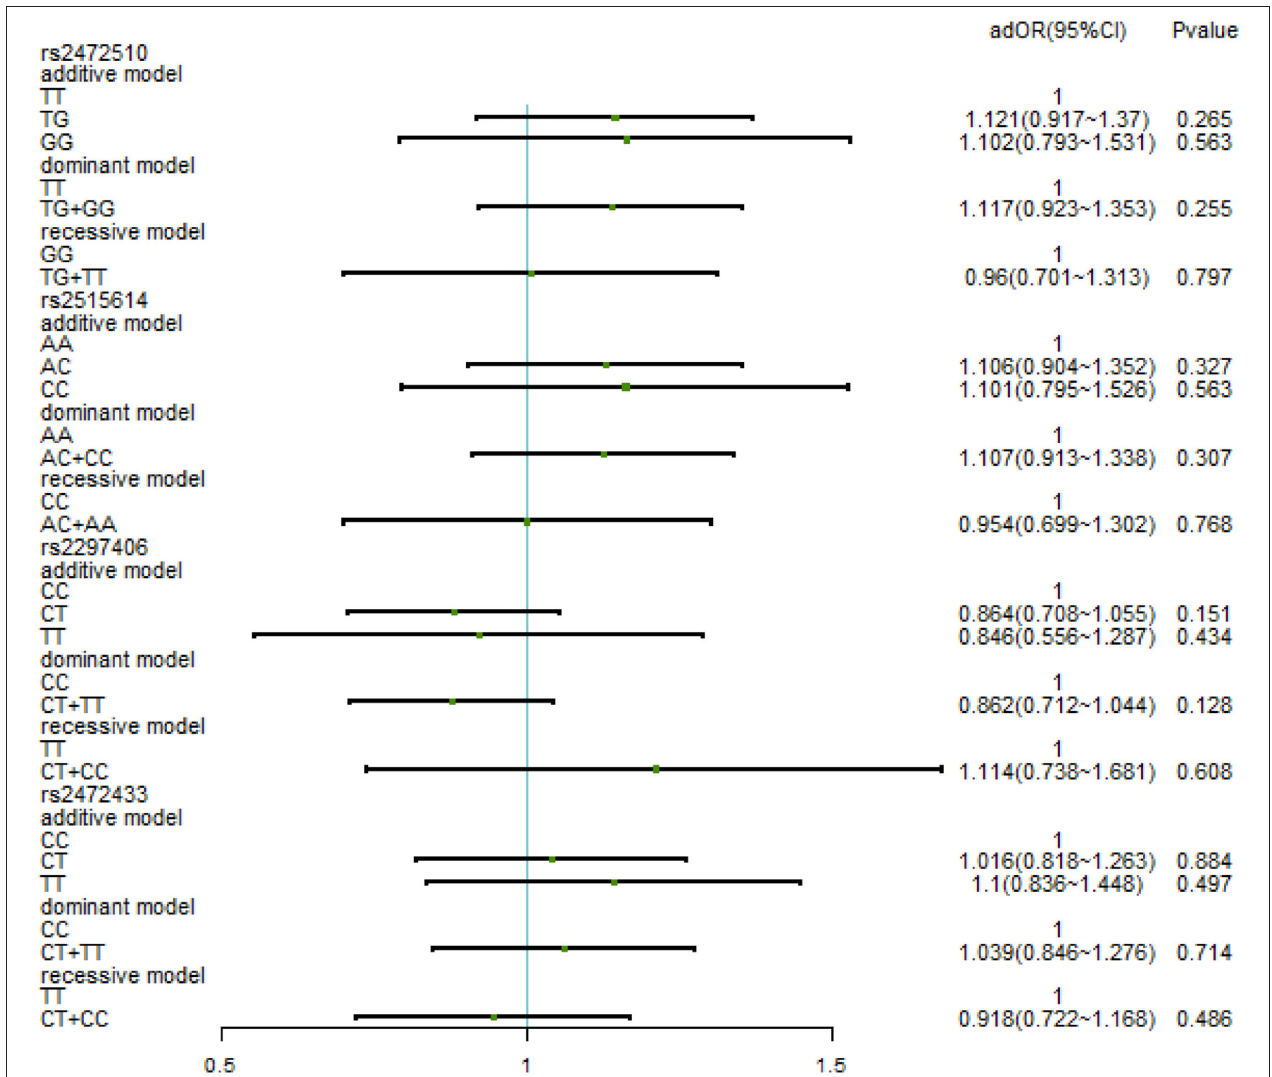
FIGURE 3 | Binary logistic regression analysis for association between genotypes of rs2472510, rs2515614, rs2297406, rs2472433, and high SBP. Adjusted some covariates, such as age, BMI, waist circumference, TC (total cholesterol)/TG (triglyceride)/LDL-C (low-density lipoprotein)/HDL-C (high-density lipoprotein cholesterol), family history, education level, daily iodized salt consumption, and smoking